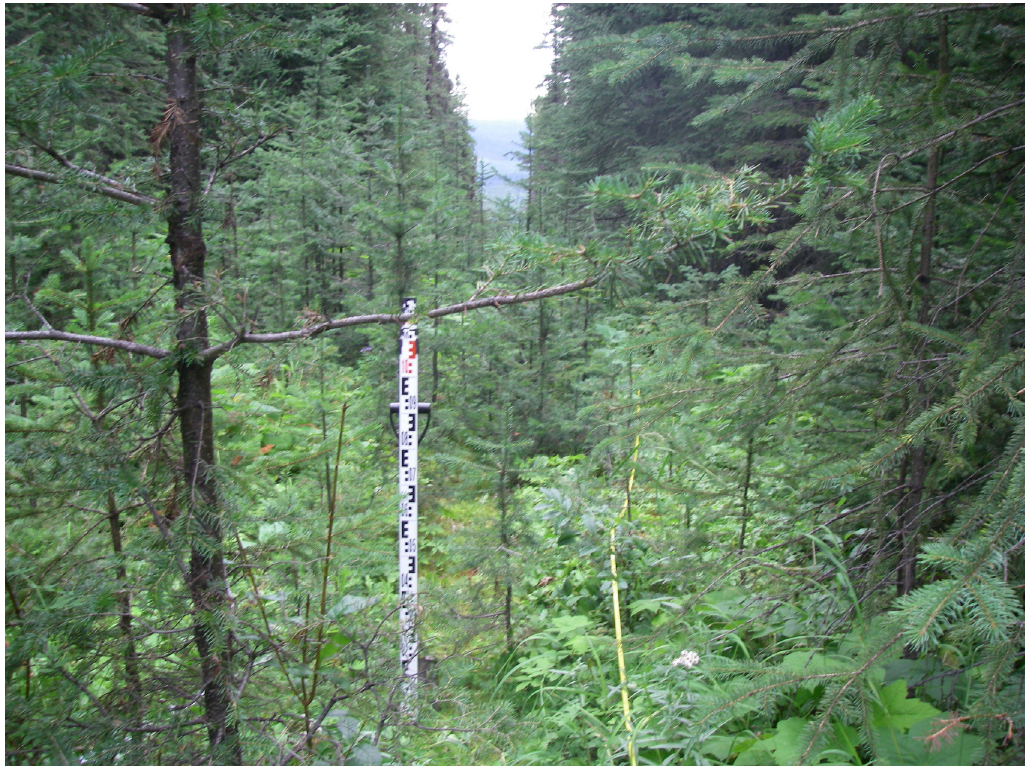
Figure 1. Natural regeneration of a typical conventional seismic line in the boreal forest. Photo courtesy of Brian